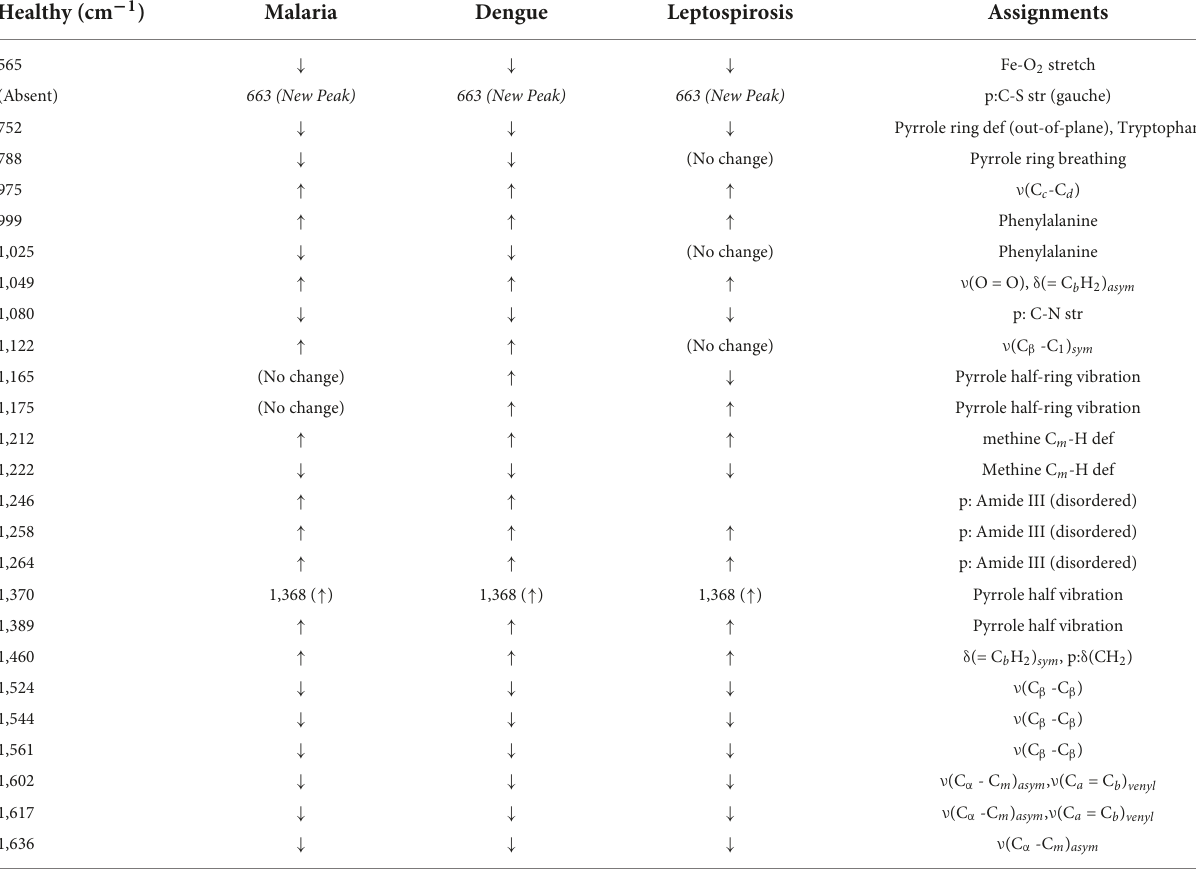
TABLE 1 Assignments of the significantly different Raman peaks of RBCs from healthy and the three disease samples that were detected through spectral analysis. Healthy (cm − 1